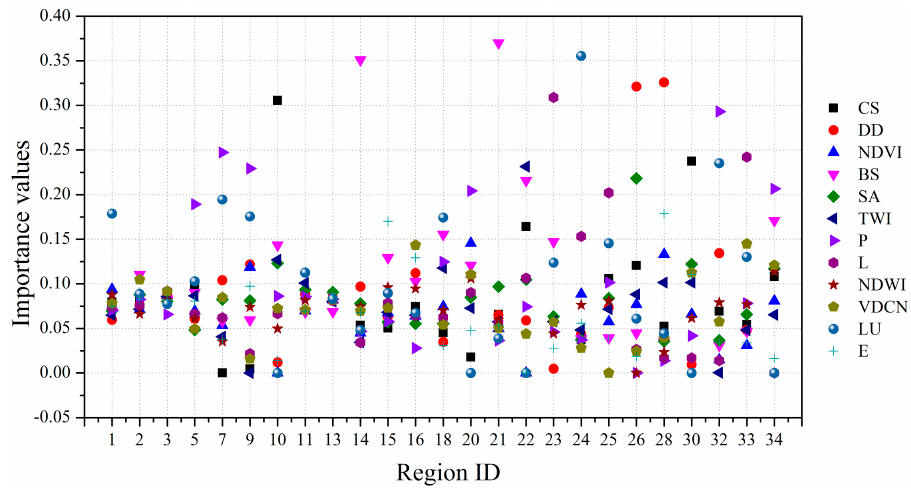
Figure 18. The importance values of the environmental factors in different prediction regions.